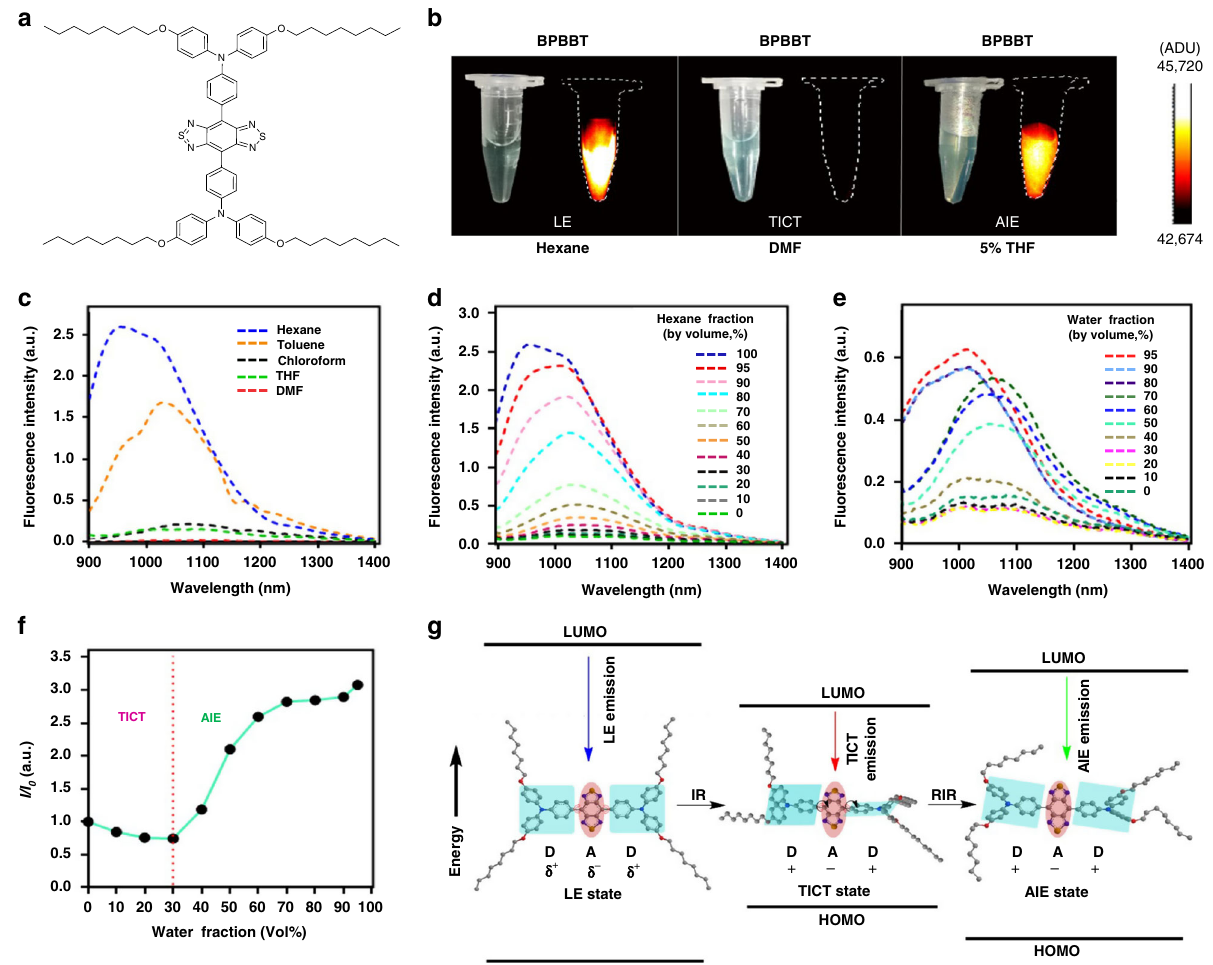
Fig. 1 Optical characterization of BPBBT. a Chemical structure of BPBBT. b Photographs and NIR-II fl uorescence images of BPBBT (10 µ M) in hexane (non- polar solvent), DMF (polar solvent) or THF containing 95% water (poor solvent for BPBBT) excited at 808 nm (100 mW cm − 2 ). LE, locally excited state; TICT, twisted intramolecular charge transfer state; and AIE, aggregation-induced emission state. c Fluorescence emission spectra of BPBBT (10 µ M) in different solvents after excitation at 831 nm. d Fluorescence emission spectra of BPBBT (10 µ M) in hexane/THF mixture with hexane fraction from 0 to 100% excited at 831 nm. e Fluorescence emission spectra of BPBBT (10 µ M) in water/THF mixture with water fraction from 0 to 95% excited at 831 nm. f Plot of I / I 0 of BPBBT versus water fraction in water/THF mixture. I and I 0 represent the fl uorescence intensity of BPBBT (10 µ M) in water/THF mixture with different water fraction and in THF, respectively. g Schematic illustration of the transformation of LE, TICT, and AIE states of BPBBT. D, donor; A, acceptor; IR, intramolecular rotation; RIR, restriction of intramolecular rotation; HOMO, Highest occupied molecular orbital; LUMO, Lowest